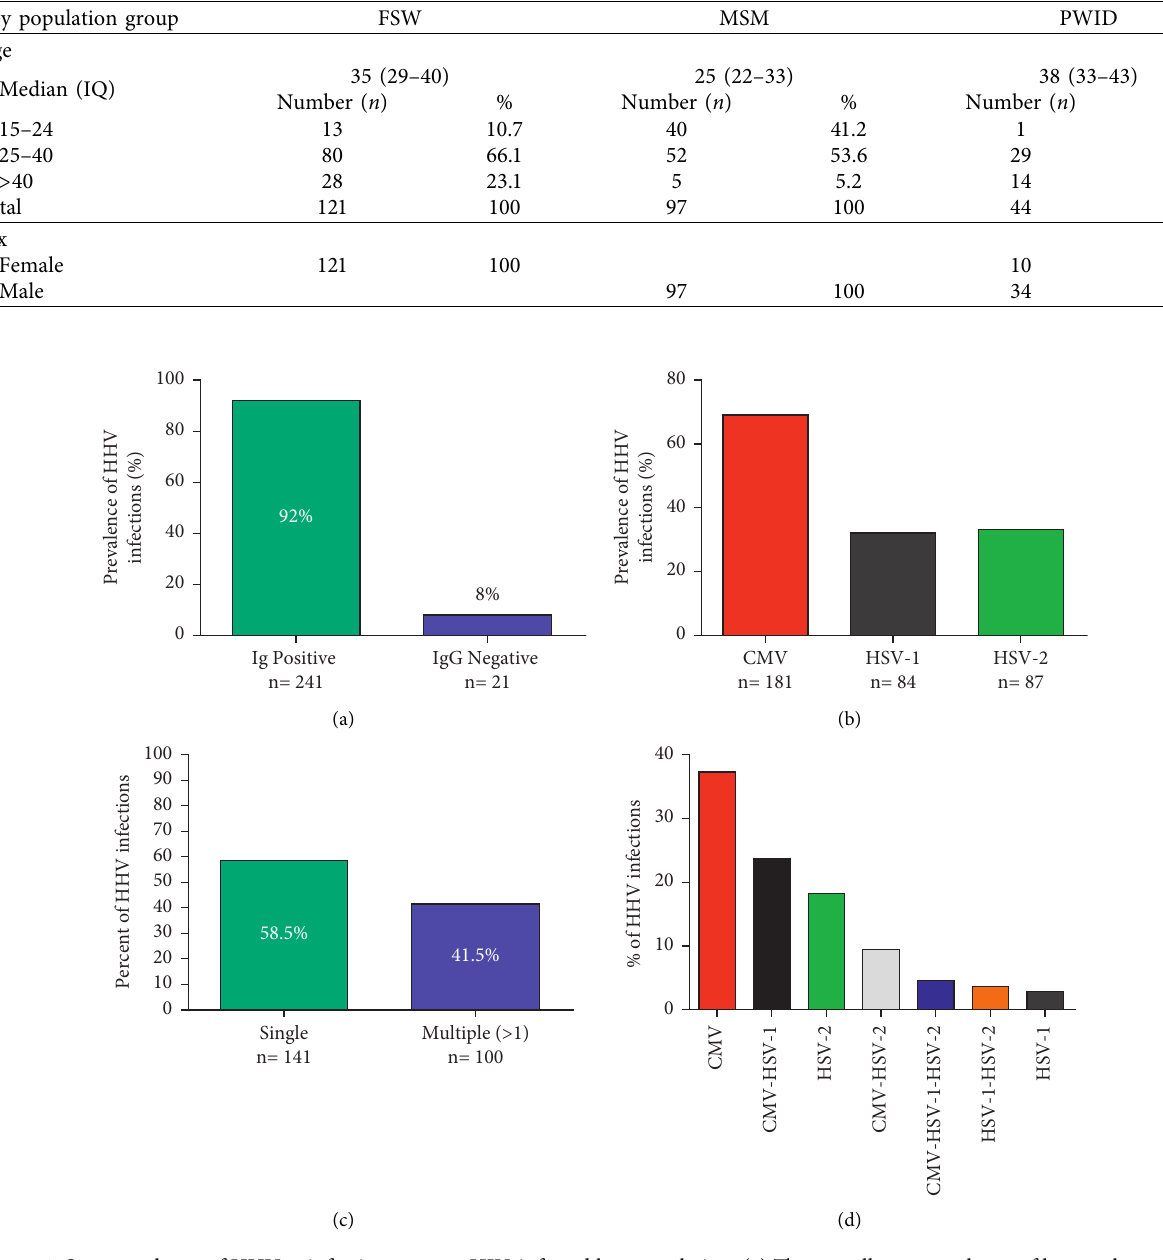
Table 1: Summary of HIV-infected key populations characteristics.